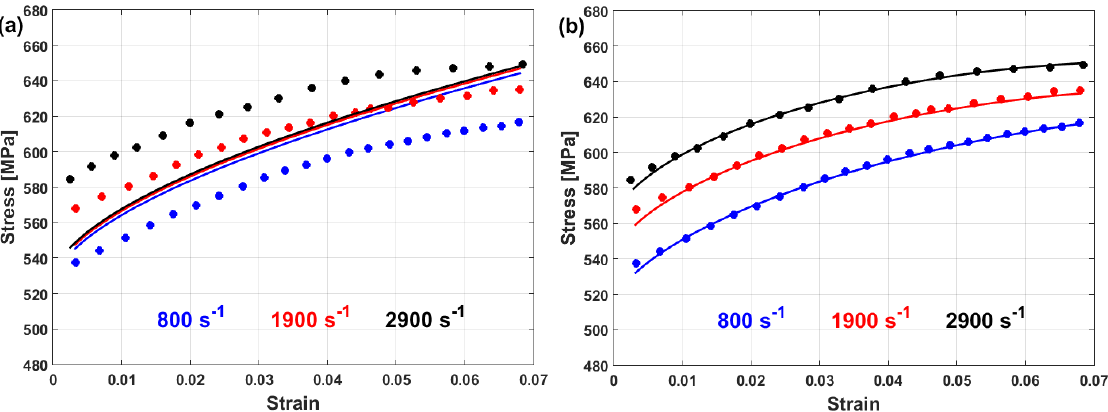
Figure 30. Experimental stresses (markers) compared to predicted stresses (solid lines) for 7050- T7451 aluminum alloy using ( a ) the original JC and ( b ) the modified JC model that was presented by Tan et al. [53].